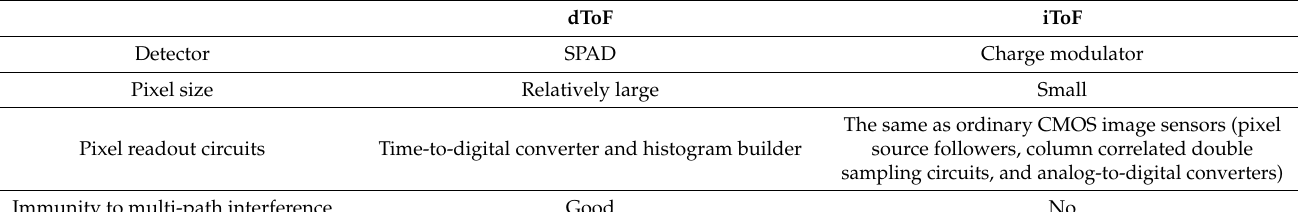
Table 1. Comparison of dToF and